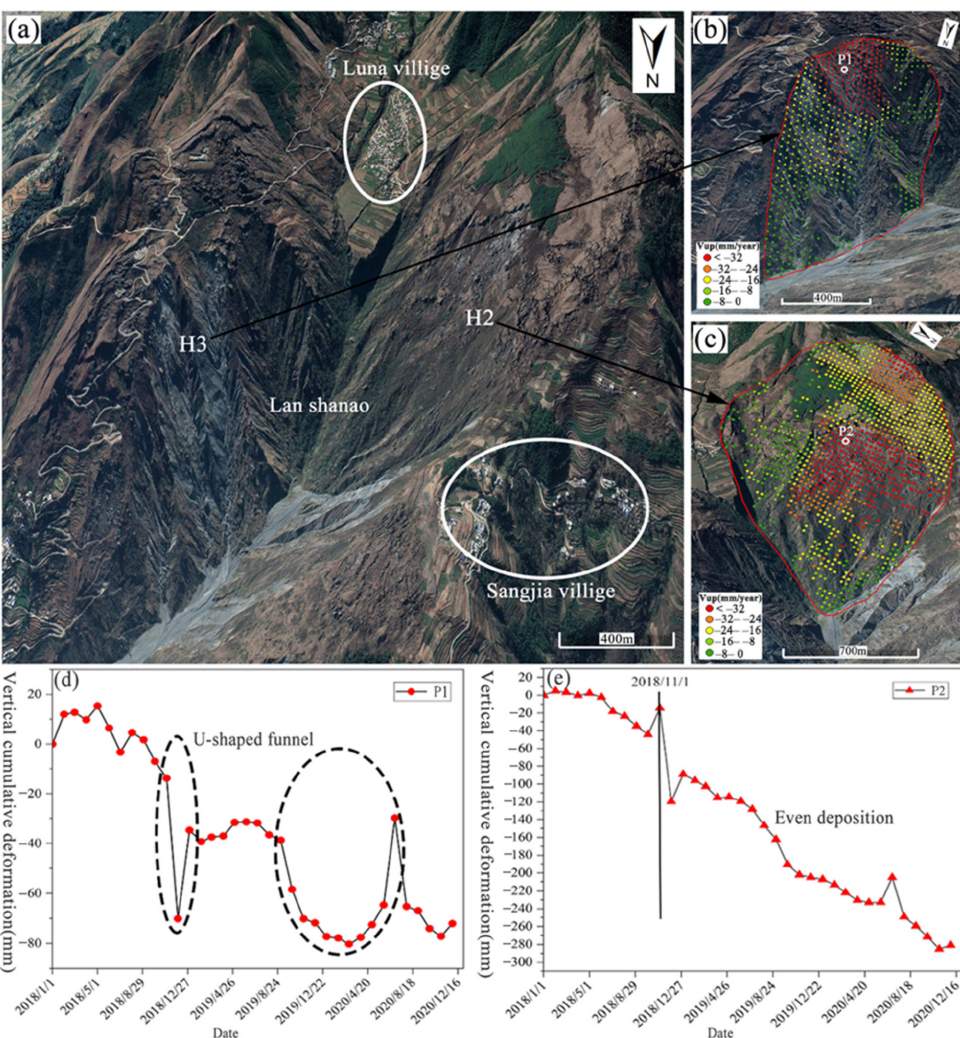
Figure 7. Typical regional remote sensing images and cumulative deformation time series of feature points. ( a ) is remote sensing image, ( b , c ) are H3 and H2 regional zooms, respectively, and ( d , e ) are the cumulative deformation time series of feature points P1 and P2,